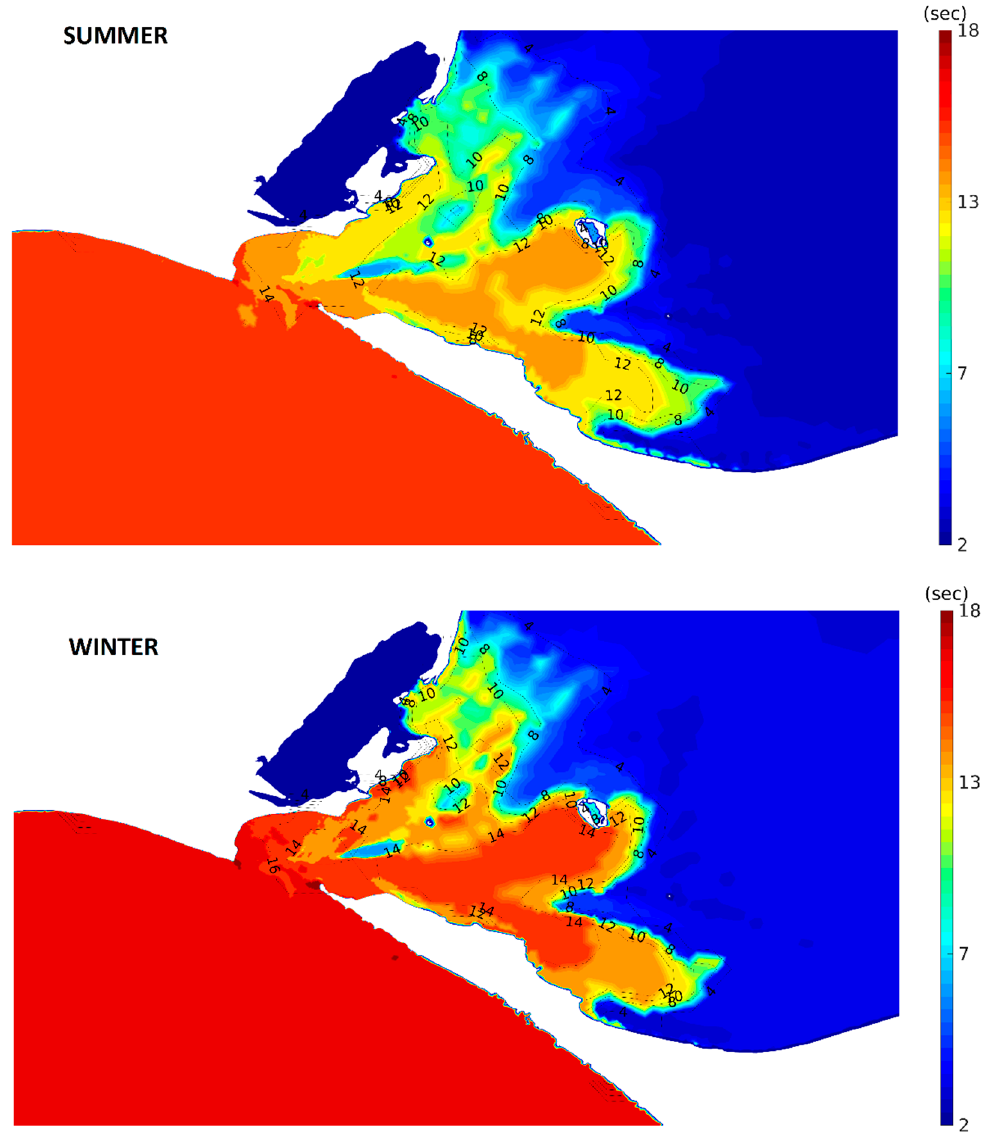
Figure 12. The 90th percentile wave peak period during summer and winter estimated from 27-year hindcasts.